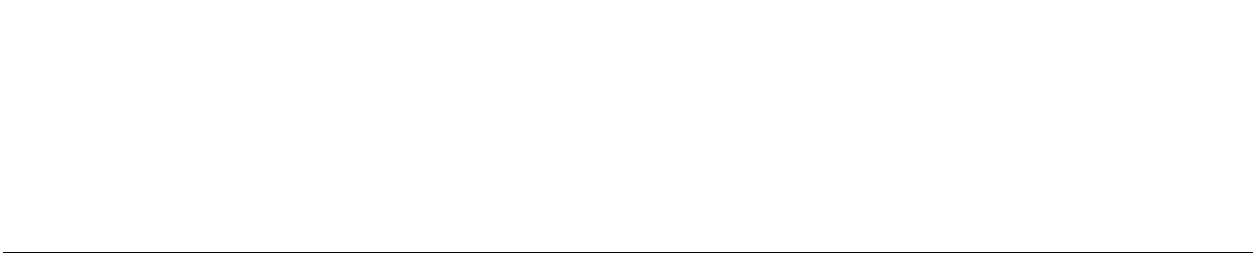
Frontiers in Human Neuroscience